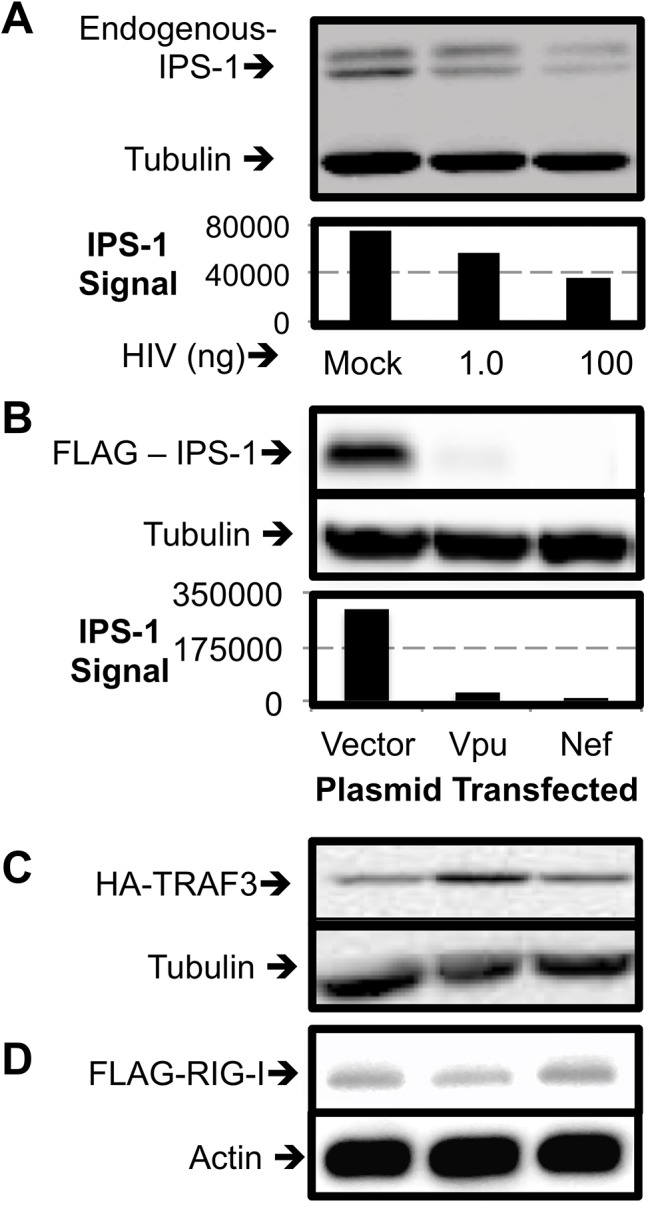
Vpu and Nef Lead to Diminished IPS-1 Expression.(A) CEM T cells were infected with HIV and after 24 hours cell lysates were prepared and blotted for levels of endogenous IPS-1 and tubulin. In A and B HRP catalysed light release was digitally recorded and displayed as a picture as well as quantified as a measure of the target band intensity divided by the intensity of the tubulin cell loading control. (B) HEK 293T cells were transfected with IPS-1 expression plasmid with a FLAG tag and the indicated plasmids. Whole cell lysates were analysed by Western blot for the expression of FLAG and tubulin. (C) HEK 293T cells were transfected with TRAF3 expression plasmid with a HA tag and the indicated plasmids. Whole cell lysates were Western blotted for the expression of HA and tubulin. (D) HEK 293T cells were transfected with RIG-I expression plasmid with a FLAG tag and the indicated plasmids. Whole cell lysates were Western blotted for the expression of FLAG and actin.